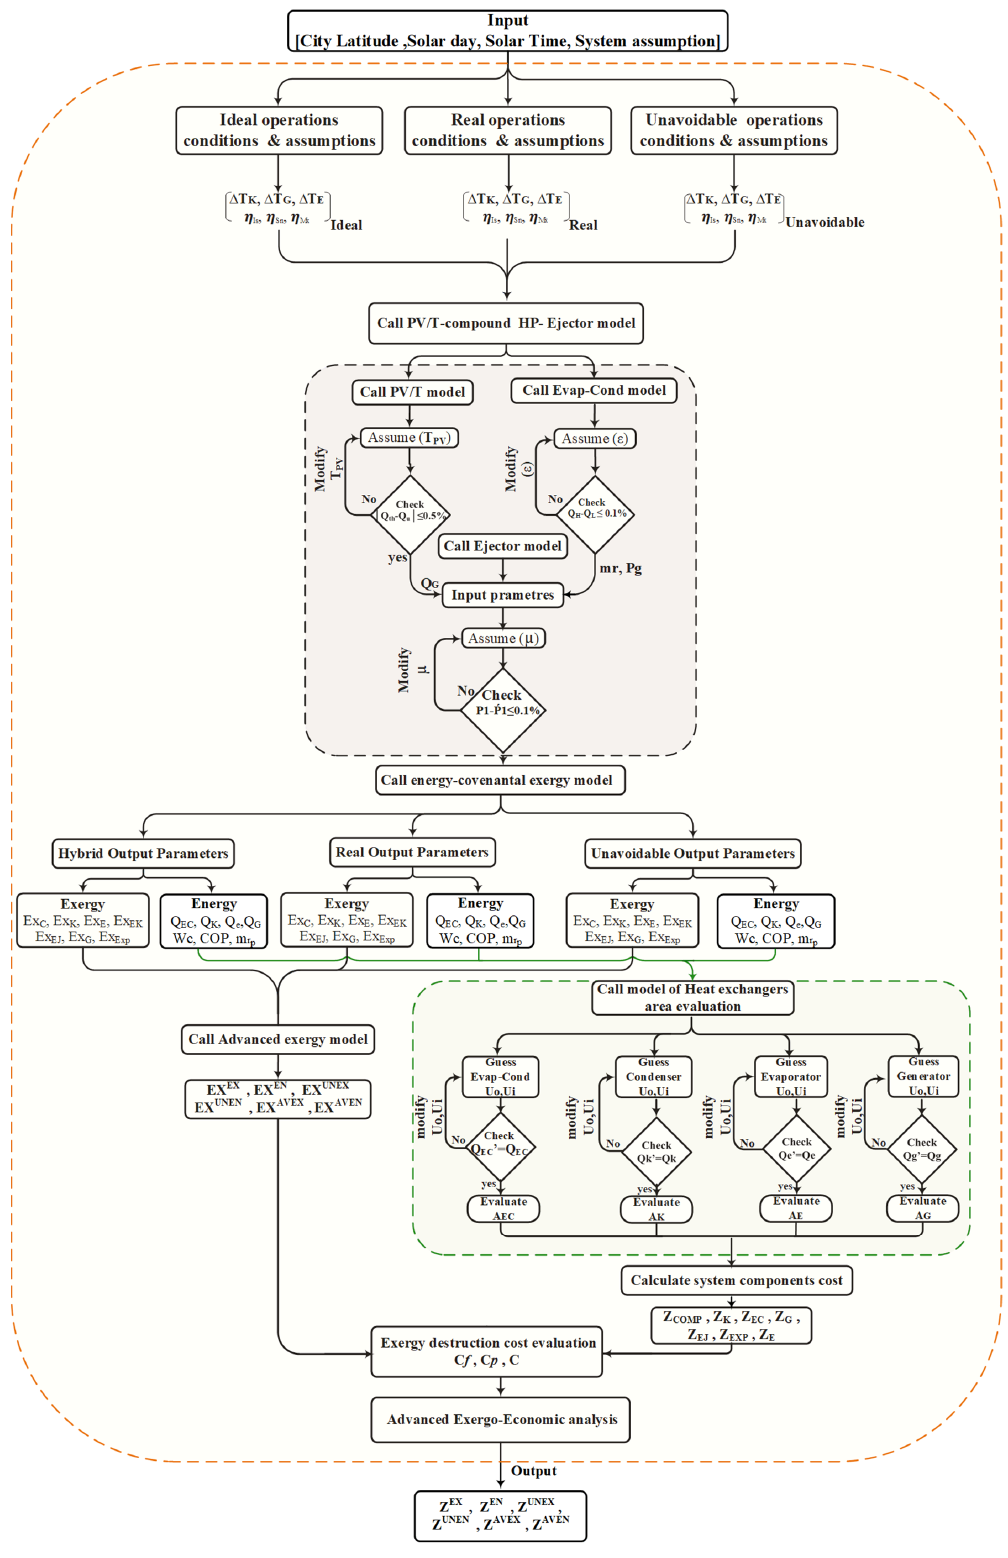
Figure 2. Flow diagram for the system methodology.